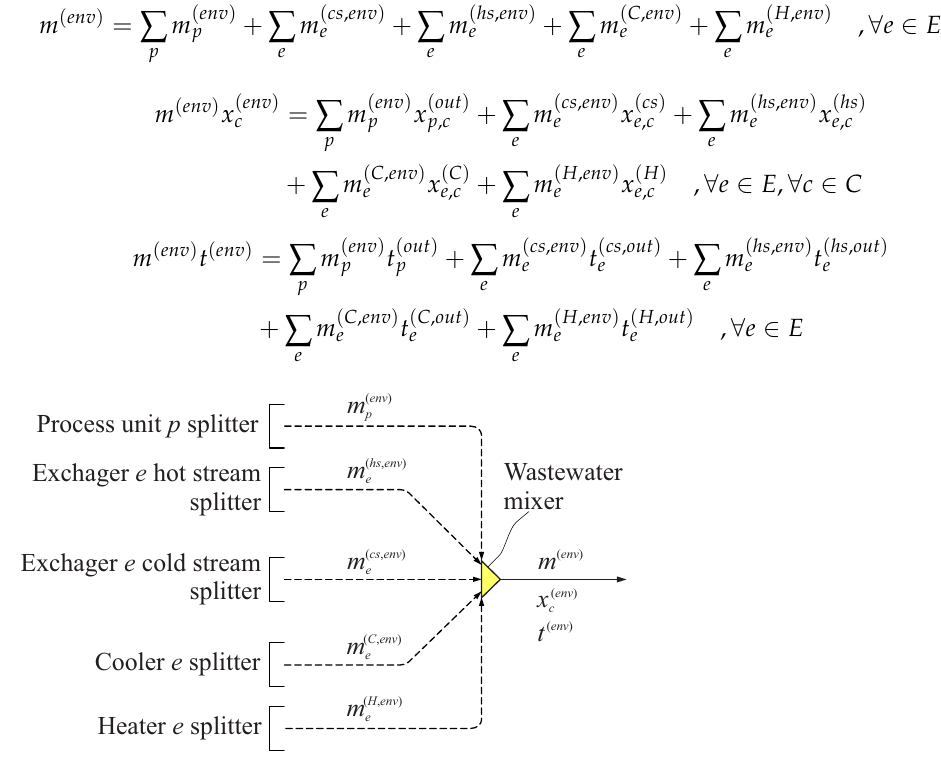
Figure 9. Wastewater mixer with corresponding